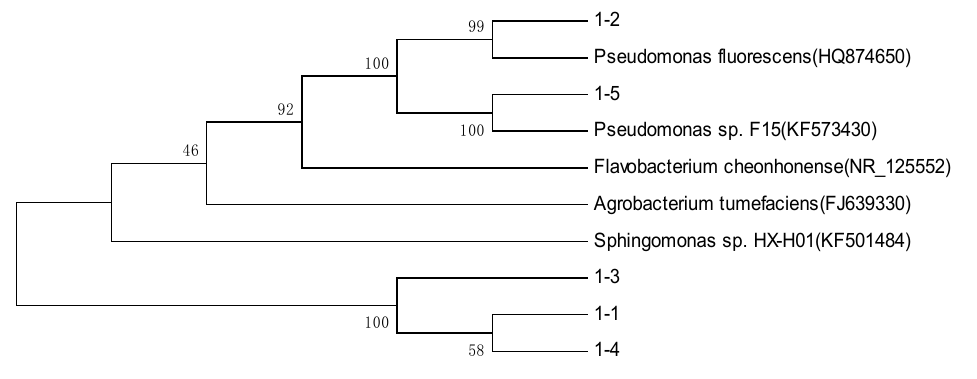
Figure 5. The phylogenetic tree of related bacteria. Table 3. Comparison of bacteria isolated from filtered water in a water plant and related microorganisms.